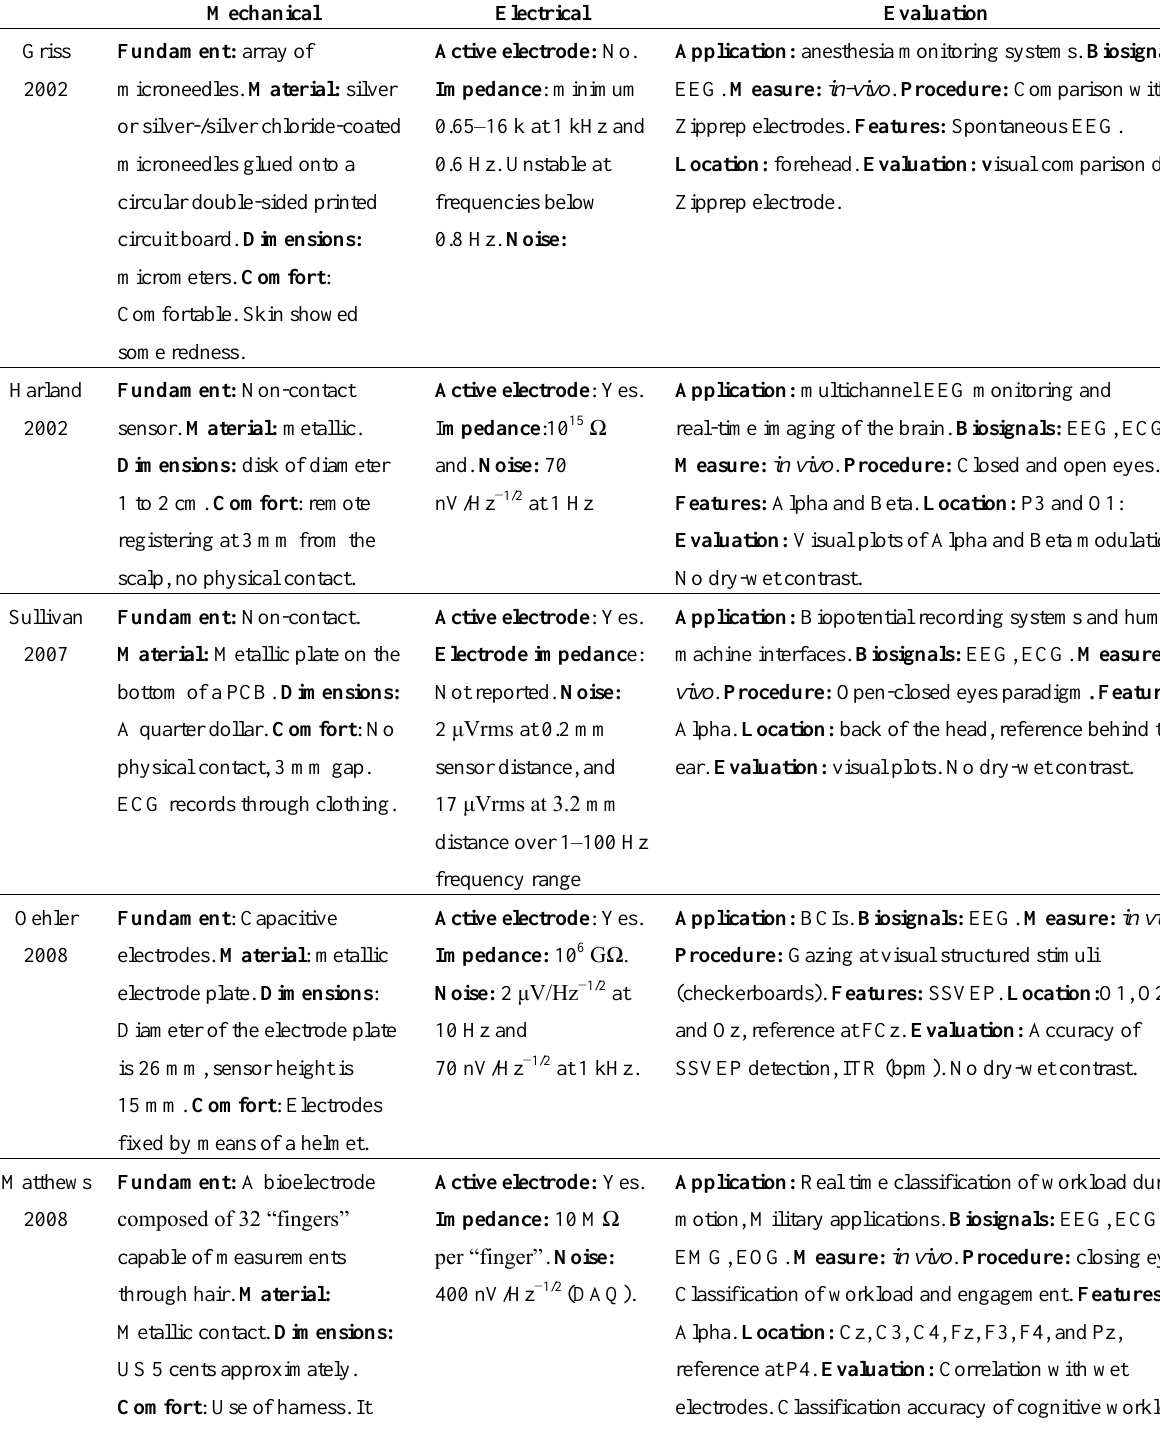
Table 4. Details of relevant studies on dry electrodes and evaluation. Mechanical Electrical